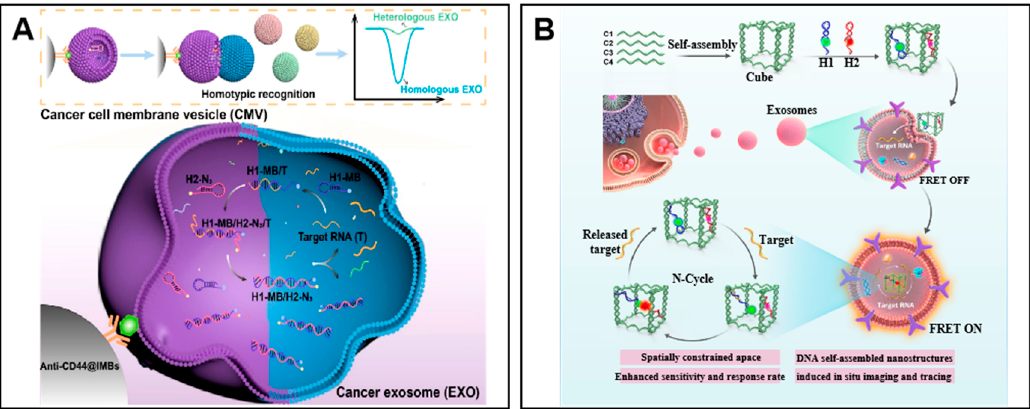
Figure 6. Examples of in situ detection of Exo-miRNA. ( A ) Schematic of homotypic recognition-driven membrane fusion for exo-miRNA detection. Reprinted with permission from [85]. Copyright 2022 American Chemical Society. ( B ) Schematic of the assembled DNA cube machine for penetration of the exosomes. Adapted with permission from [86]. Copyright 2022 American Chemical Society.